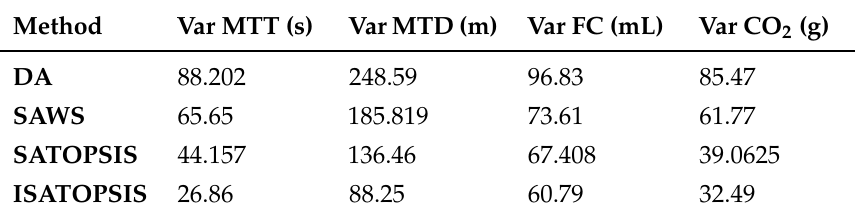
Table 4. The overall average variance (Var) results obtained by all algorithms in the tested scenarios.